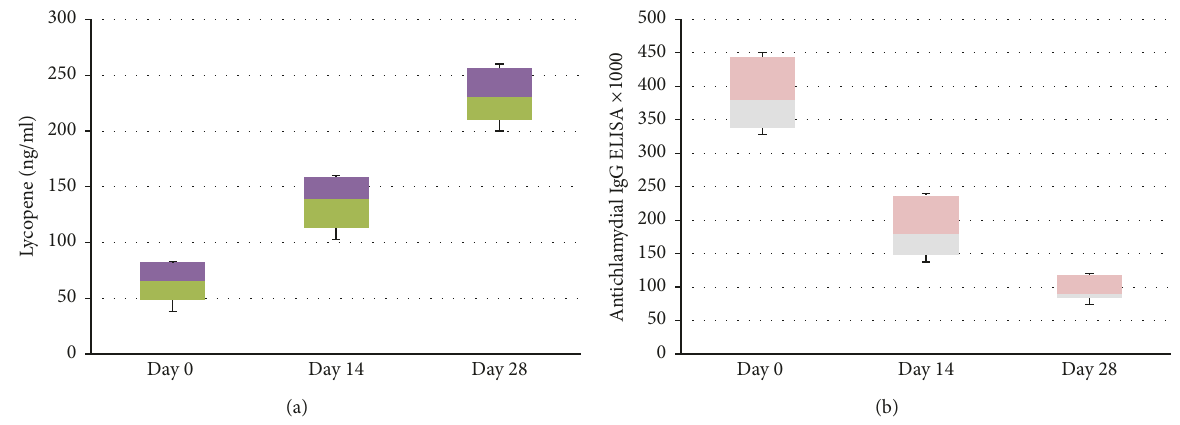
Figure 7: Changes in serum lycopene level (a) and serum chlamydia-specific IgG antibodies (b) in volunteers treated with 7 mg of GA lycopene for 28